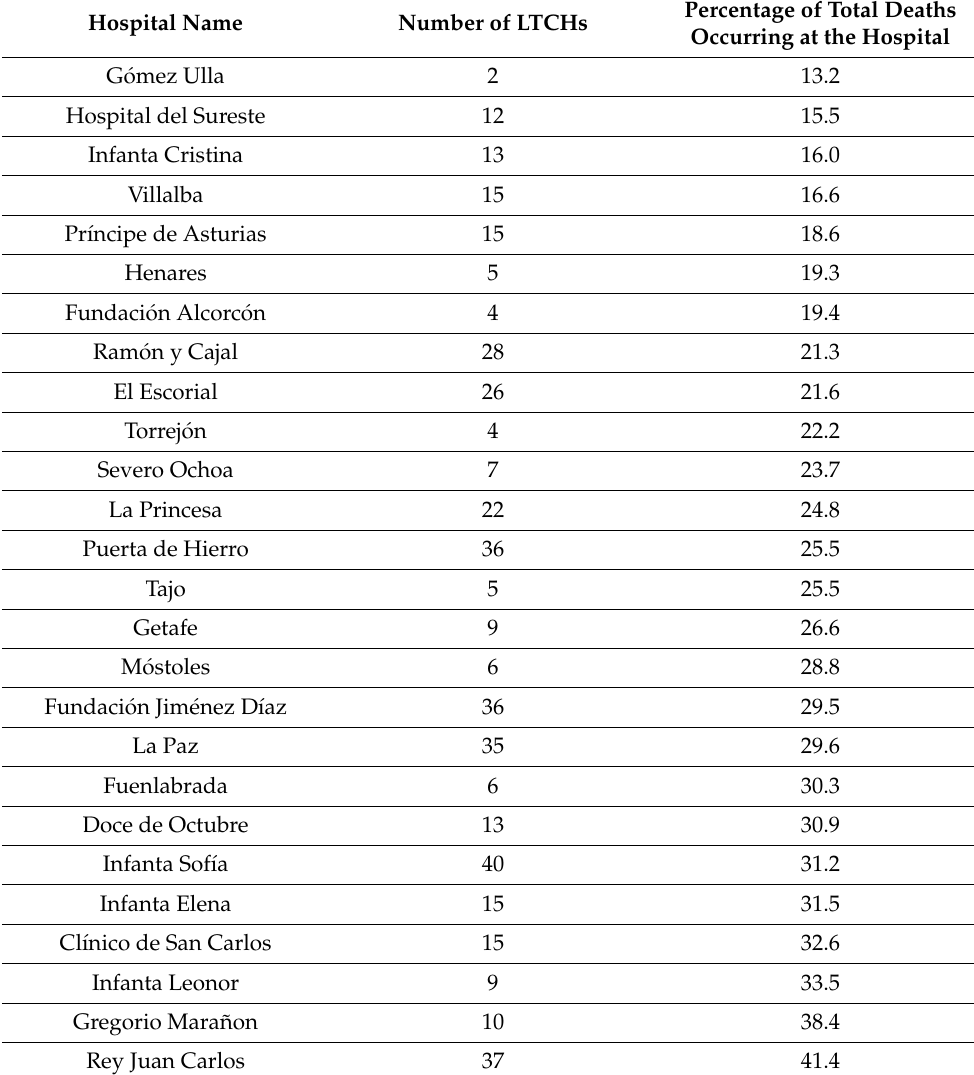
Table 3. Percentage of total deaths occurring after transfer to the hospital during March–April